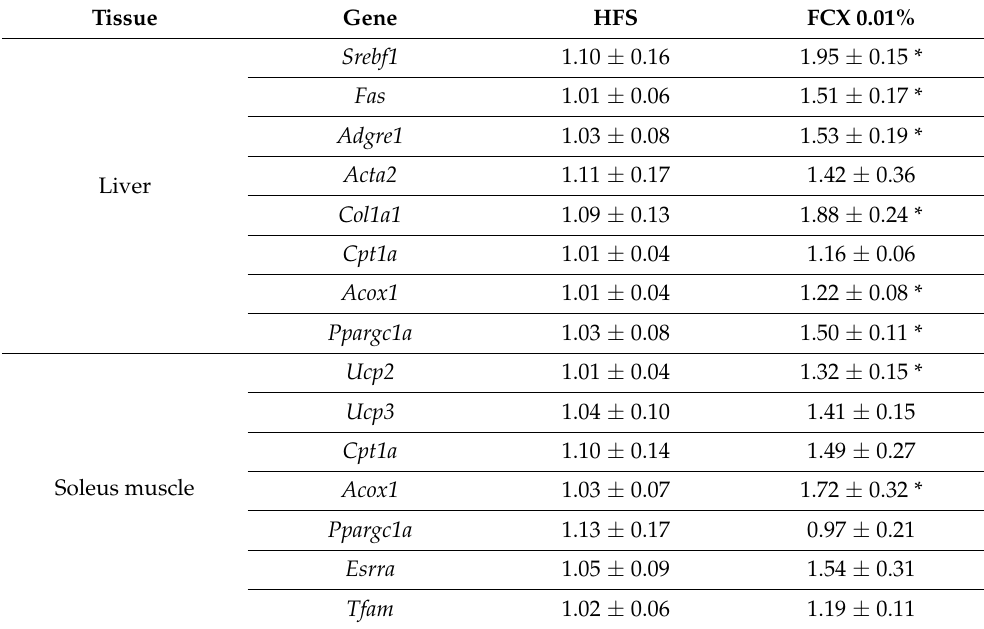
Figure 7. Effect of FCX on hepatic steatosis and fibrosis in DIO mice fed HFS control or FCX 0.01% for 8 weeks. ( a ) Liver weight. ( b ) Serum ALT levels. ( c ) Liver TG and TC levels. n = 9–11 per group. Data mean ± SEM. *, p < 0.05 between two groups. Table 1. Gene analysis in the liver and soleus muscle of C57BL/6J mice fed HFS or FCX 0.01% for 8 weeks.